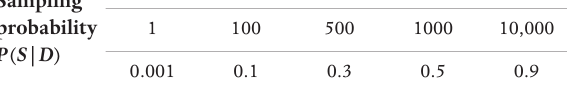
Table 6. Percentiles of the Landscan distribution of population for all of Kyrgyzstan. The distribution has an extended dynamic range, exceeding 42dB, with 95% of the grid population values below 63, and 99% of the grid cells with less than 1000